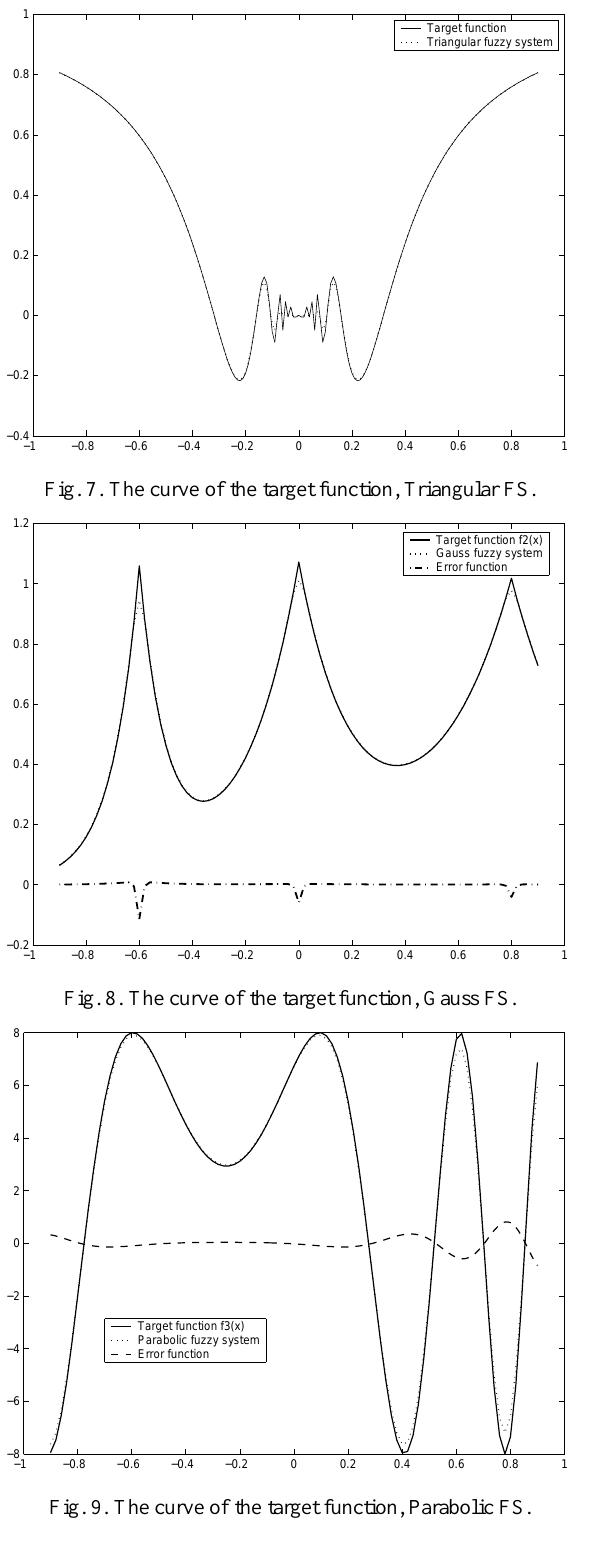
Fig. 9. The curve of the target function, Parabolic FS.